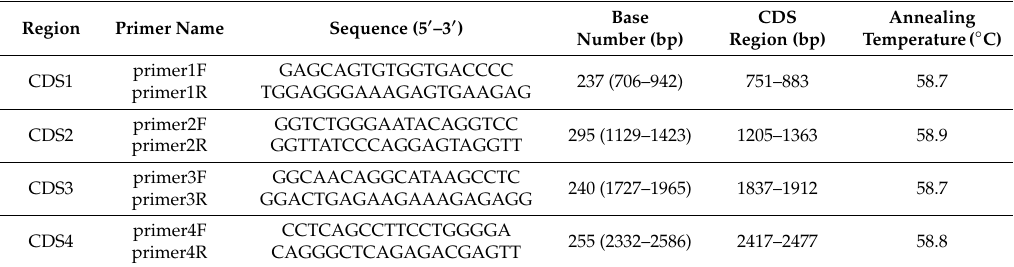
Table 1. Conventional PCR amplification primers for the four CDS and their adjacent regions of the α -LA gene